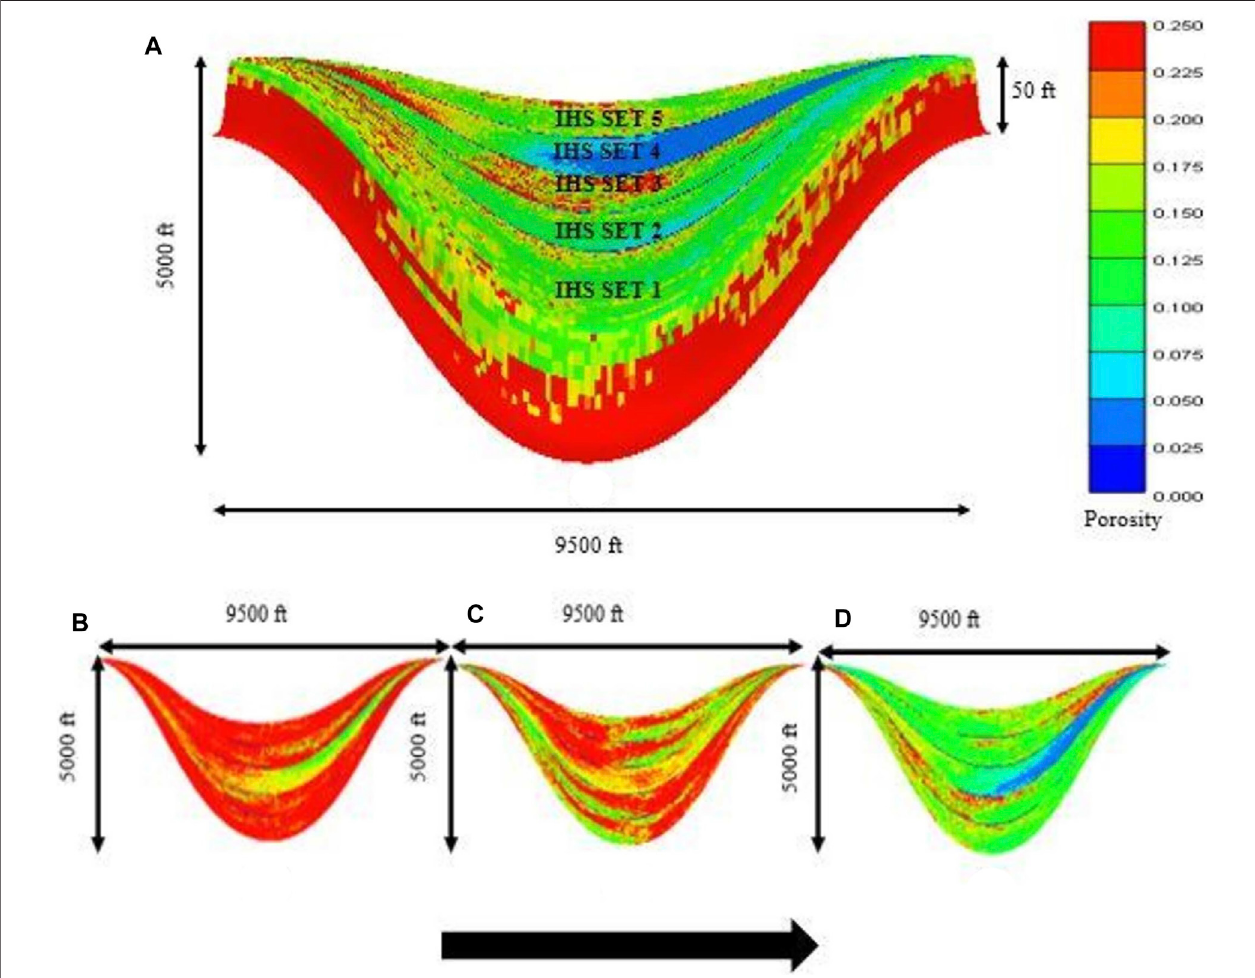
FIGURE8|(A) singleSGSIMrealizationofpropertydistributionforthevariousIHSsetswithinthepointbar.Downstreamdirectionisfromlefttoright. (B) Horizontal slices taken at the bottom, (C) mid-section and (D) top of the point bar, showing fi ning upward trend. Arrow points to the top of the point bar.